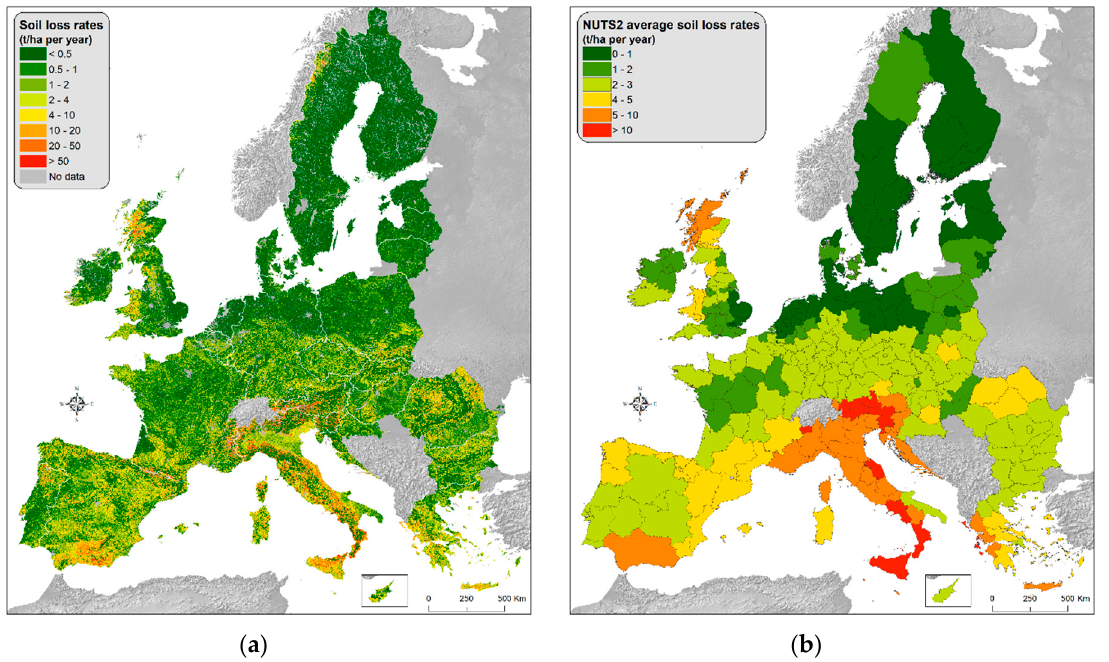
Figure 3. (a) The updated soil loss rates by water erosion (2016); (b) The indicator “estimated mean soil erosion rate (t ha -1 yr -1